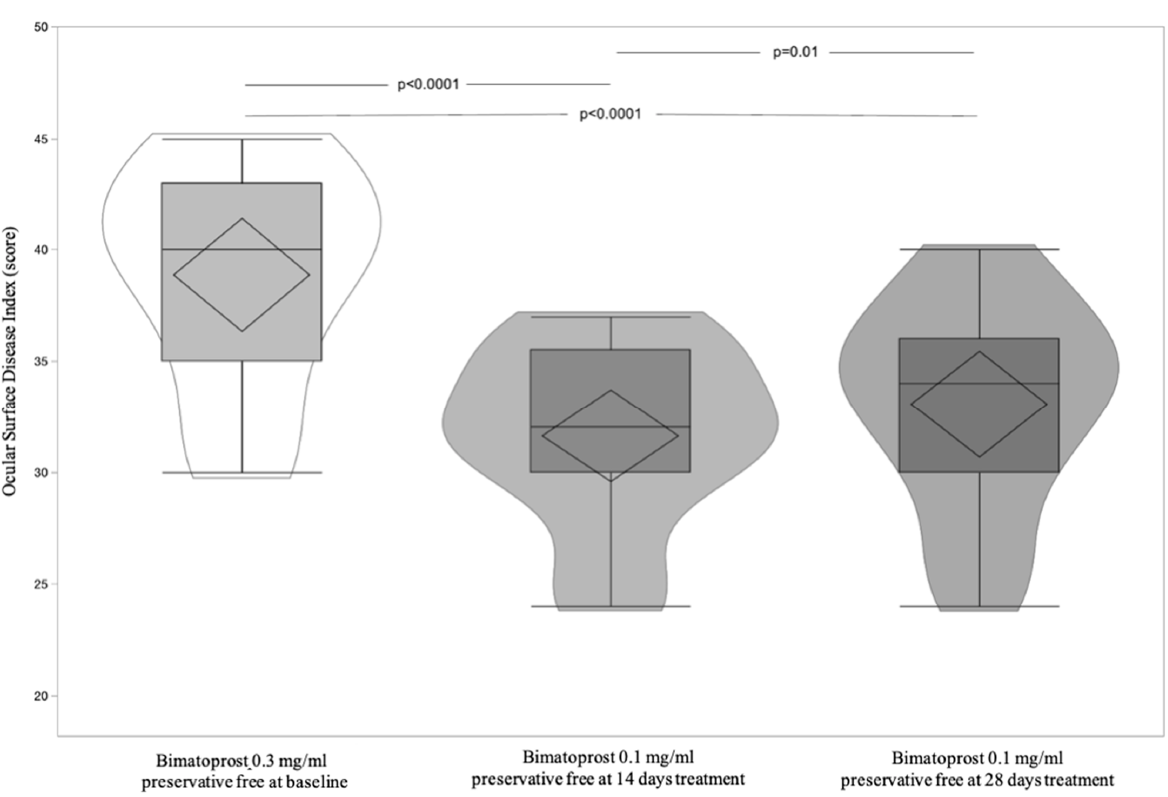
Figure 5. Violin and box-plots of the ocular surface index by Bimatoprost 0.3 mg/mL preservative-free at baseline and Bimatoprost 0.1 mg/mL preservative-free at 14 and 28 days.